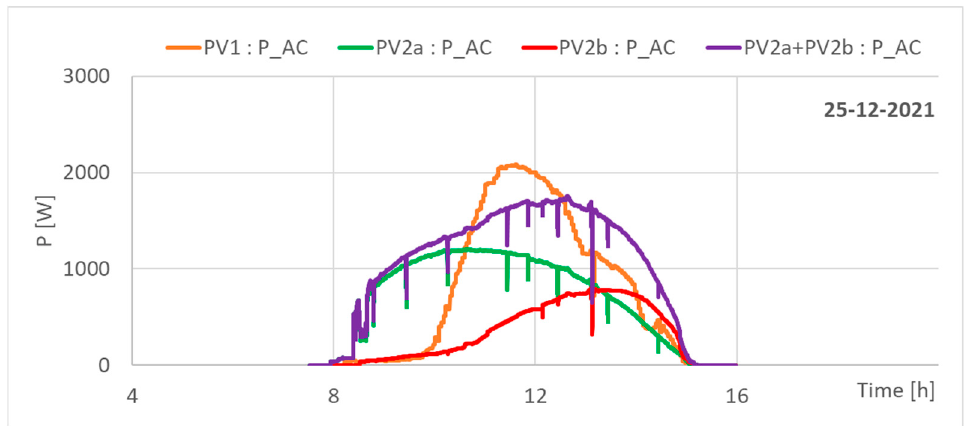
Figure 15. Instantaneous power of analyzed sections on a sunny winter day (own measurement data).